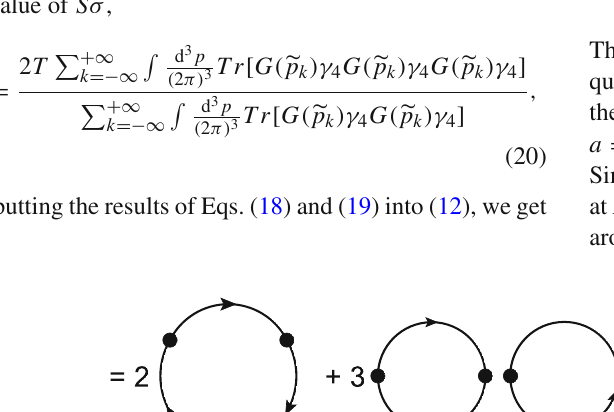
Fig. 2 Feynman diagram for